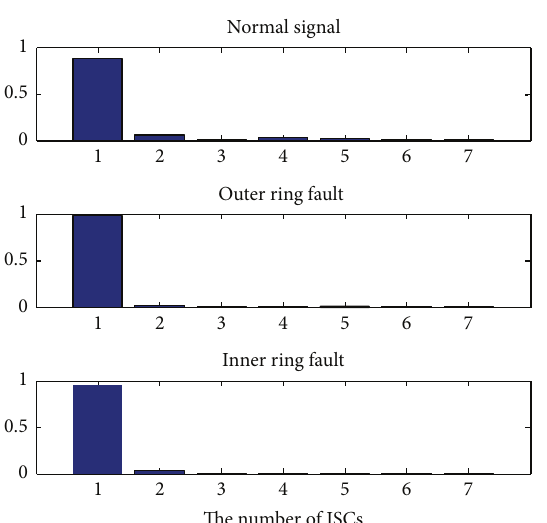
Figure8:ISCkurtosisafterdecompositionofdifferentvibrationsig- nals.